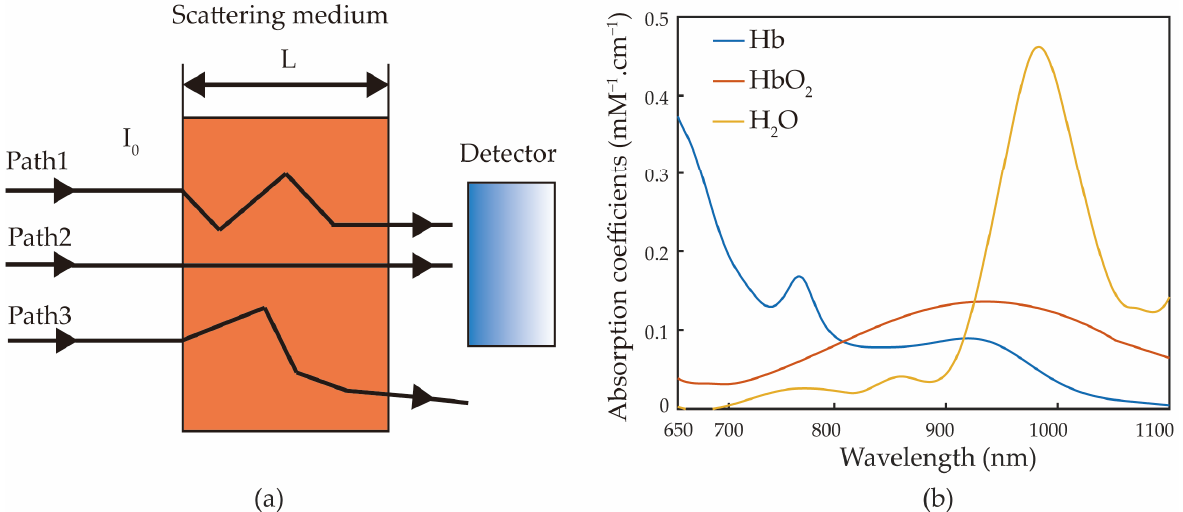
Figure 1. ( a ) Schematic of scattering, absorption of light in tissue, and detection. ( b ) Absorption coefficients of oxyhemoglobin, deoxy-hemoglobin, and water at 650–1100